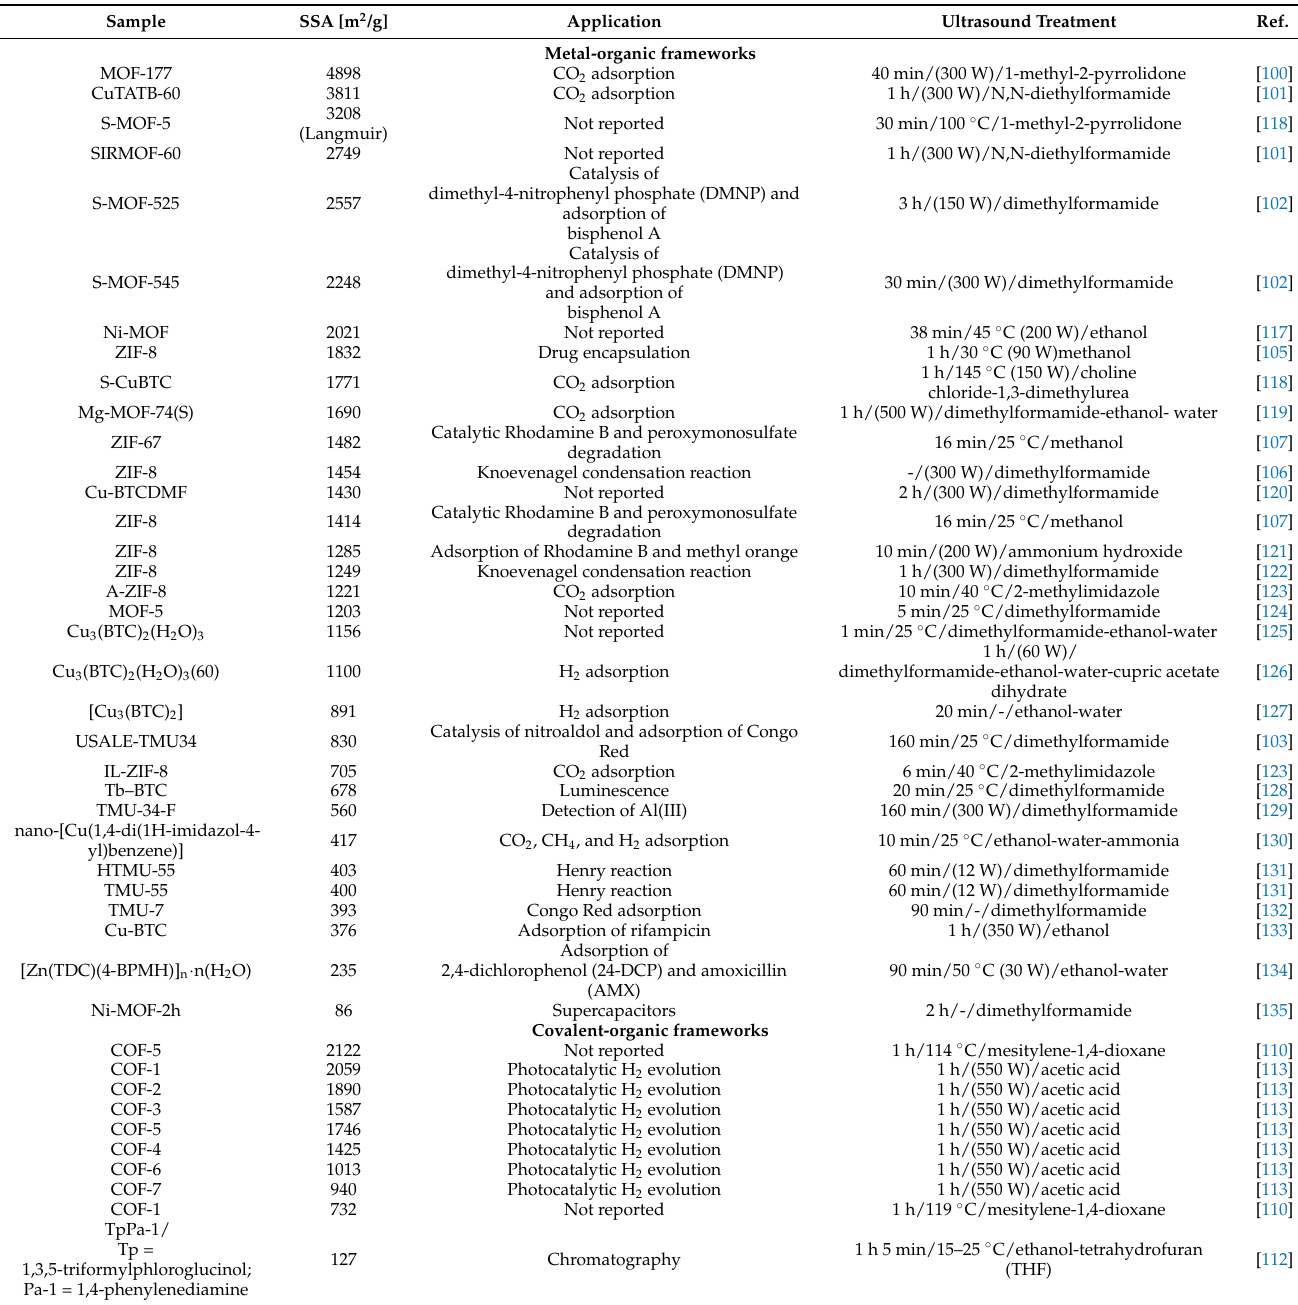
Table 4. Metal-organic frameworks and covalent-organic frameworks prepared via a sonochemical- assisted